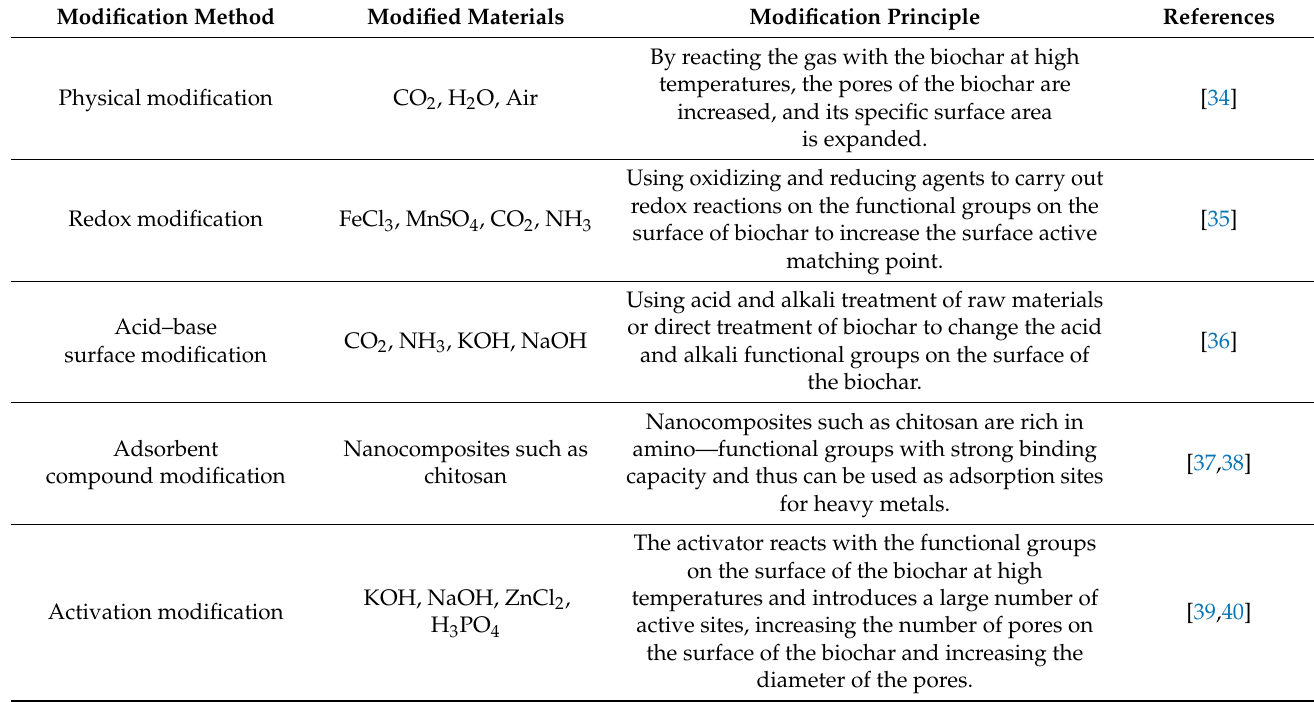
Table 2. Modification methods and principles of modified